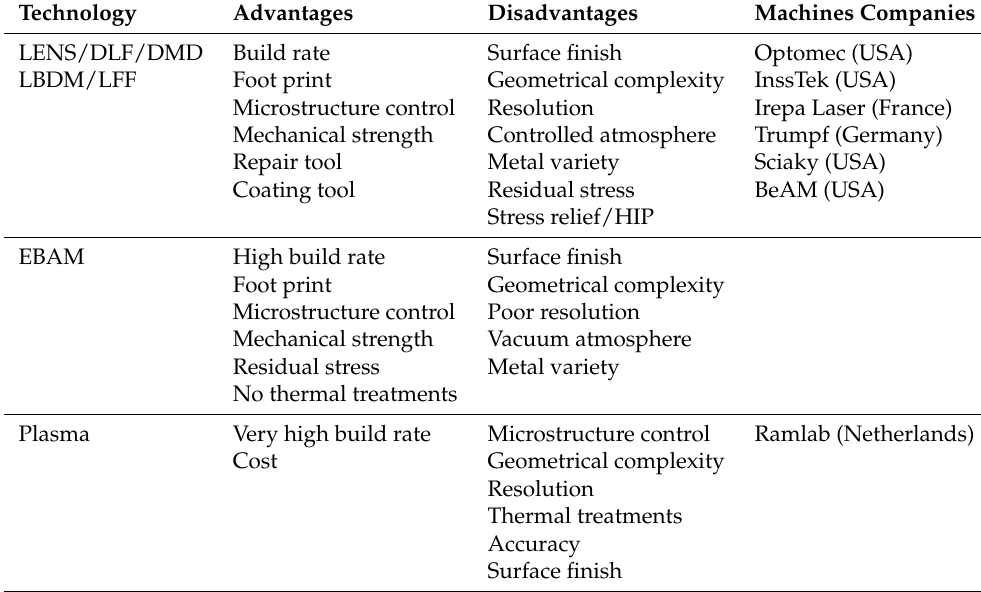
Table 3. DED process